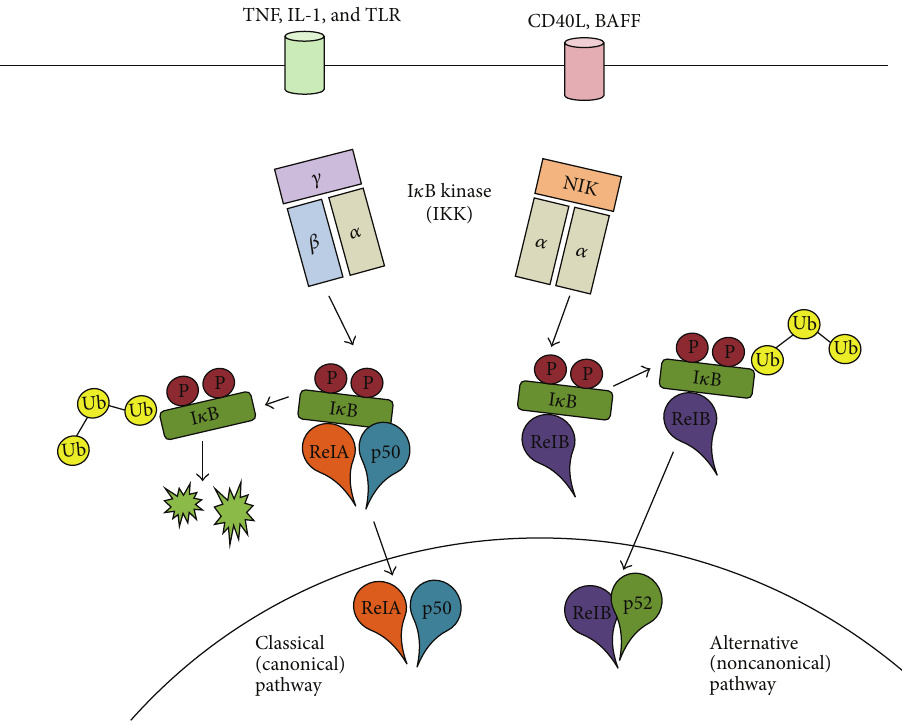
Figure 3: Two pathways leading to NF- 𝜅 B